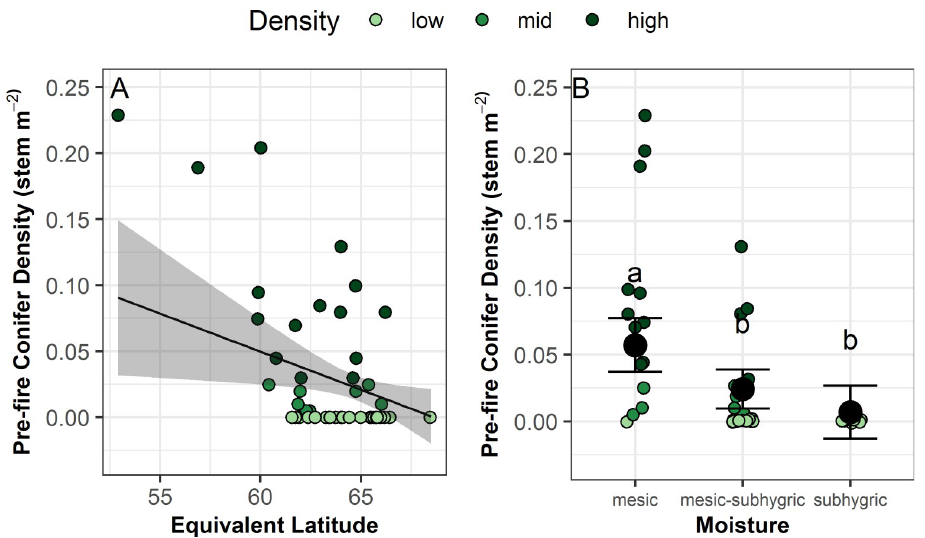
Fig 2. Pre-fire conifer density (stems � m -2 ) as a function of equivalent latitude and moisture category. In a) the black line represents modelled relationships from a linear mixed effects model with random effects of grid (2 levels). Shading represents 95% confidence regions. In b) the black circles and error bars represent model fit and 95% confidence intervals. See Table 2 for model